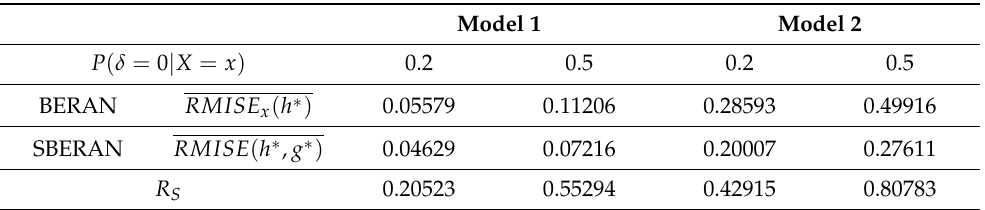
Table 3. Comparative table of the estimation error of Beran’s estimator and the smoothed Beran’s estimator in Models 1 and